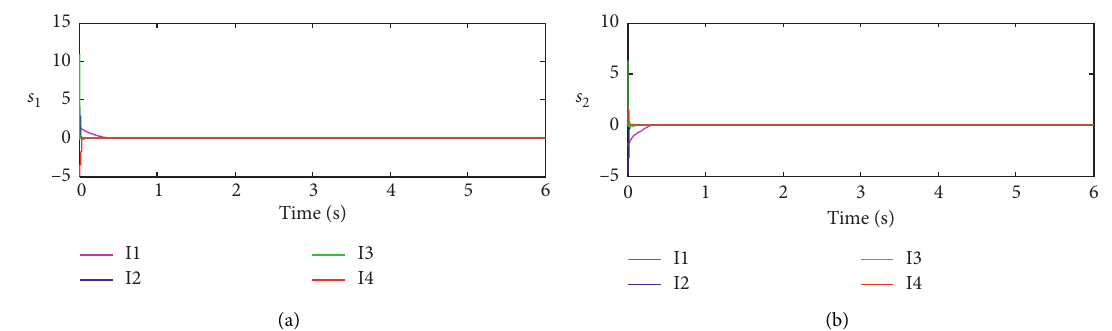
Figure 4: Sliding surfaces versus time with different initial